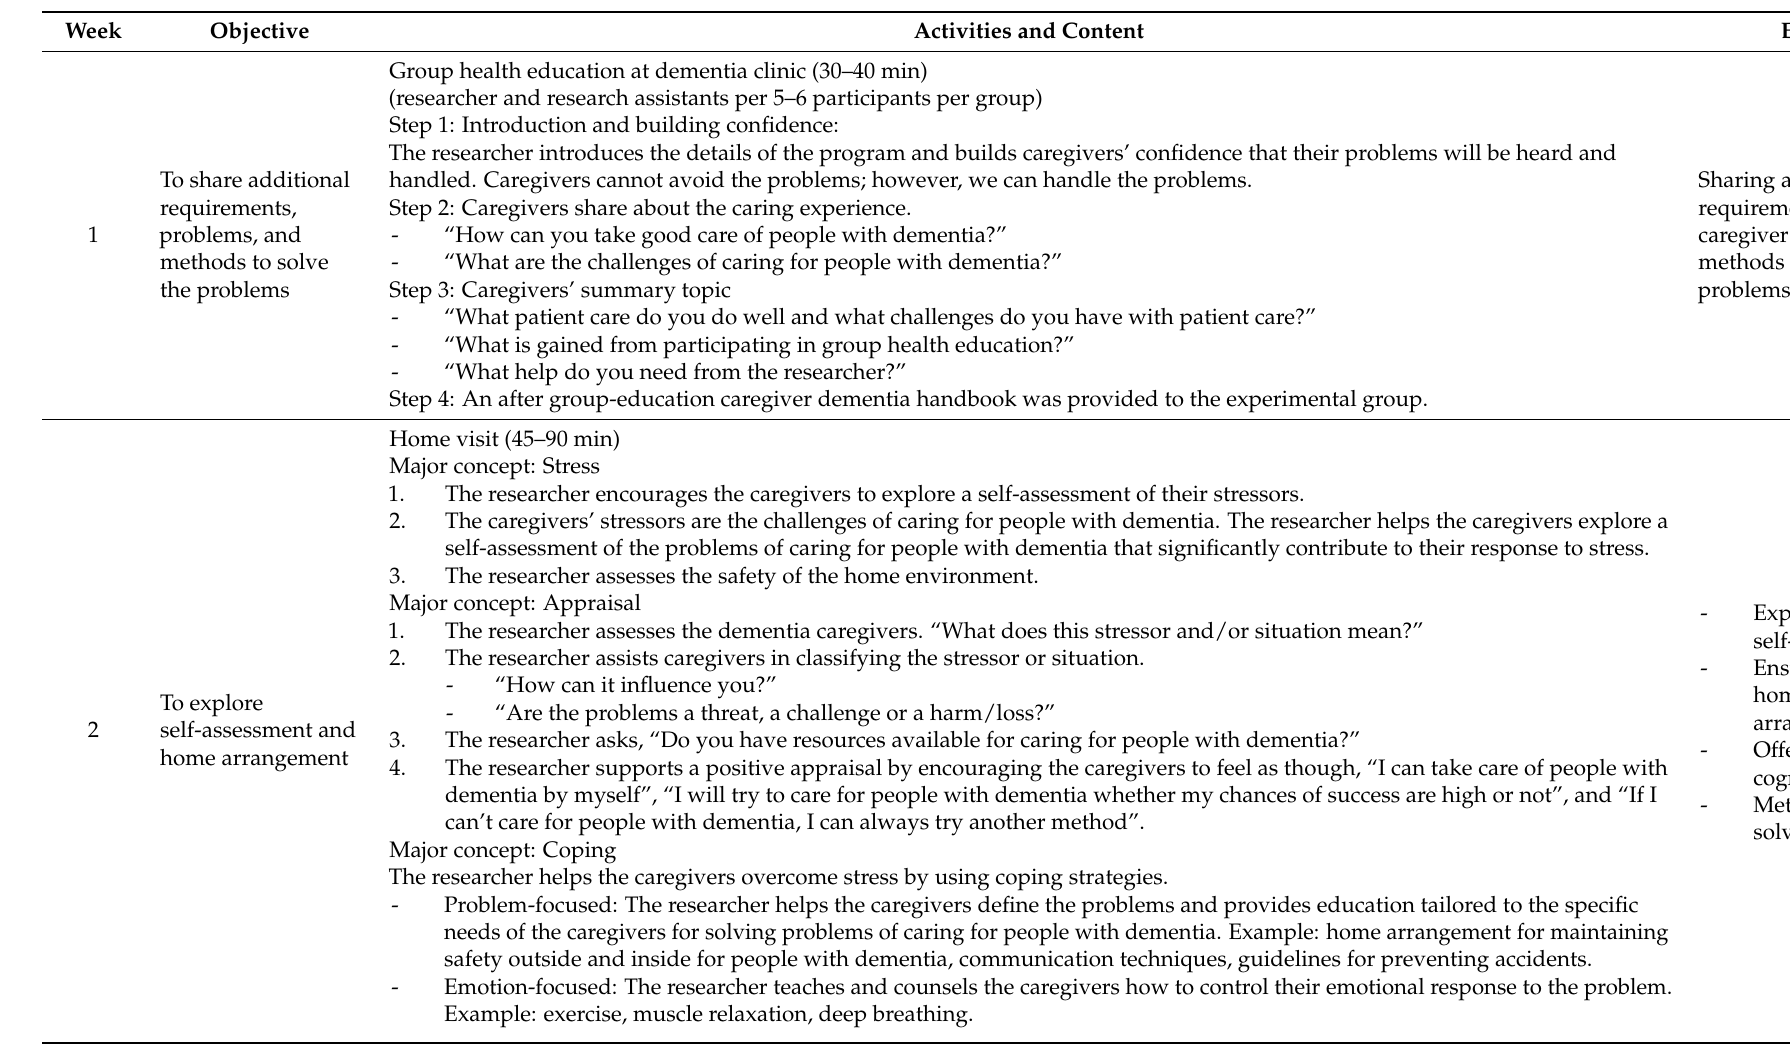
Table 1. The activities of the modified transtheoretical theory of stress and coping (TTSC)